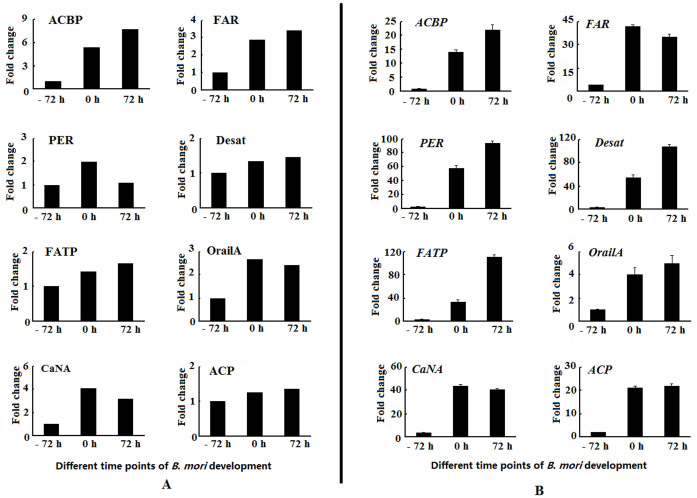
The relative expression levels of sex pheromone biosynthesis-associated proteins based on proteomic data (A) and genes (B) in PGs of different time points in B. mori development.PGs at different time points in B. mori development were dissected and total RNA was extracted for qPCR analysis. The Rp49 gene was used as the housekeeping gene for normalization. The data represent the mean values ± SD of three biological replicates. FATP: fatty acid transport protein, Desat:acyl CoA desaturase, ACBP: acyl-CoA binding protein, FAR: fatty-acyl reductase, PER: perilipin, OrailA: Orai1 alternative splice form A, CaNA: calcineurin A, ACP: acyl carrier protein.